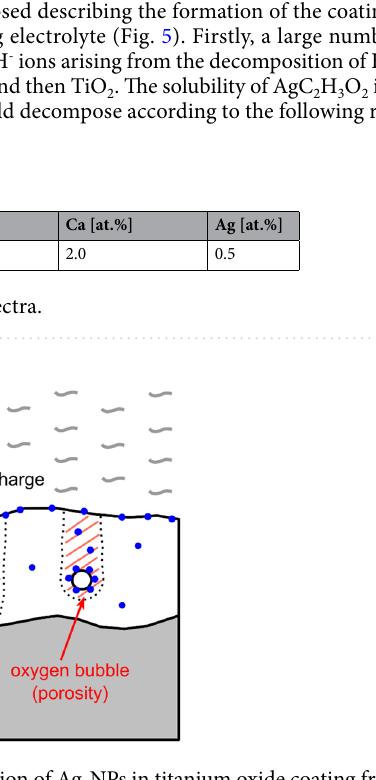
Figure 5. Scheme presenting the mechanism of incorporation of Ag-NPs in titanium oxide coating from AgC 2 H 3 O 2 containing